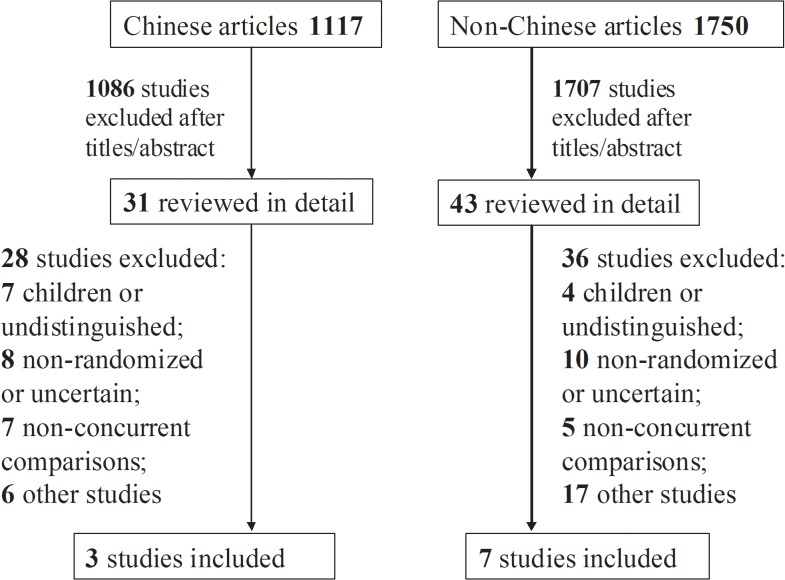
Flow chart of included studies.